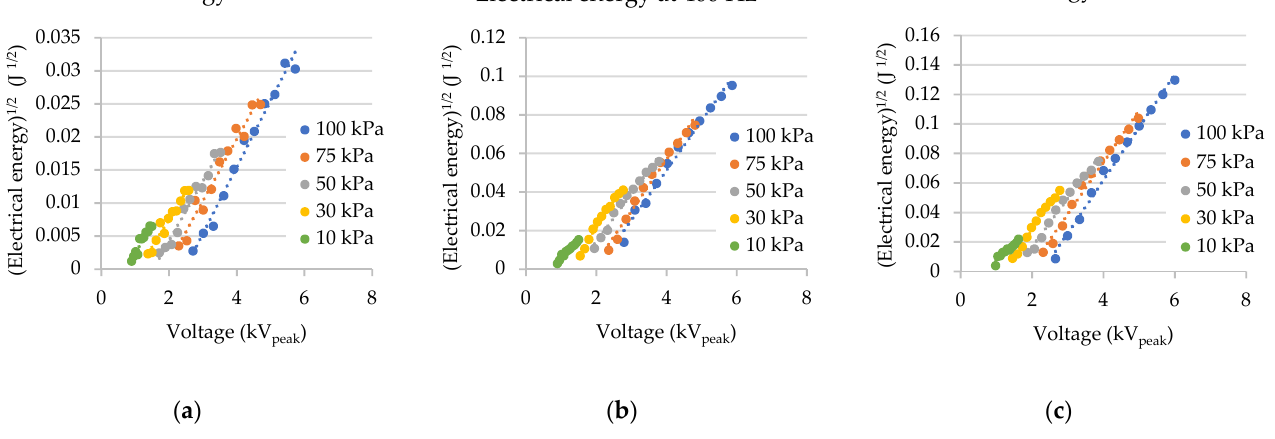
Figure 7. Experimental results of the ETFE aeronautic wires. Square root of the electrical energy versus voltage for air pressures ranging from 10 to 100 kPa. ( a ) 50 Hz, ( b ) 400 Hz, ( c ) 800 Hz.